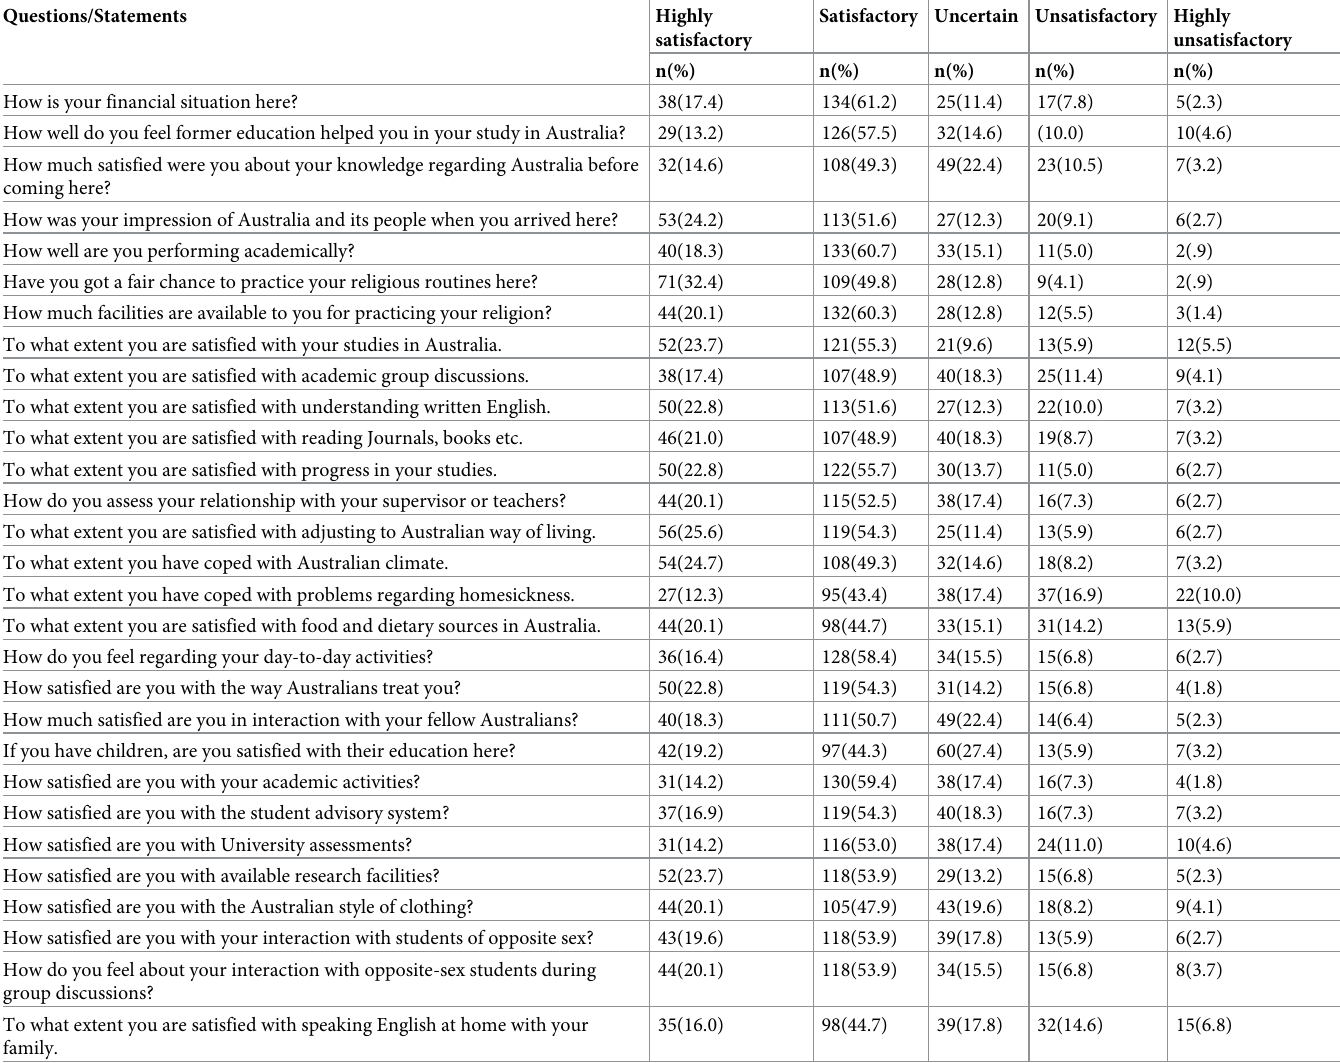
Table 3. Students’ responses to various questions on a five-point